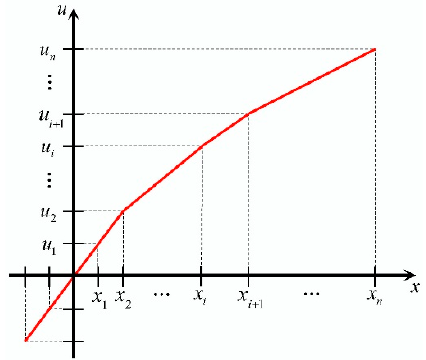
Figure 3. Schematic of the mapping function u = f ( x ).